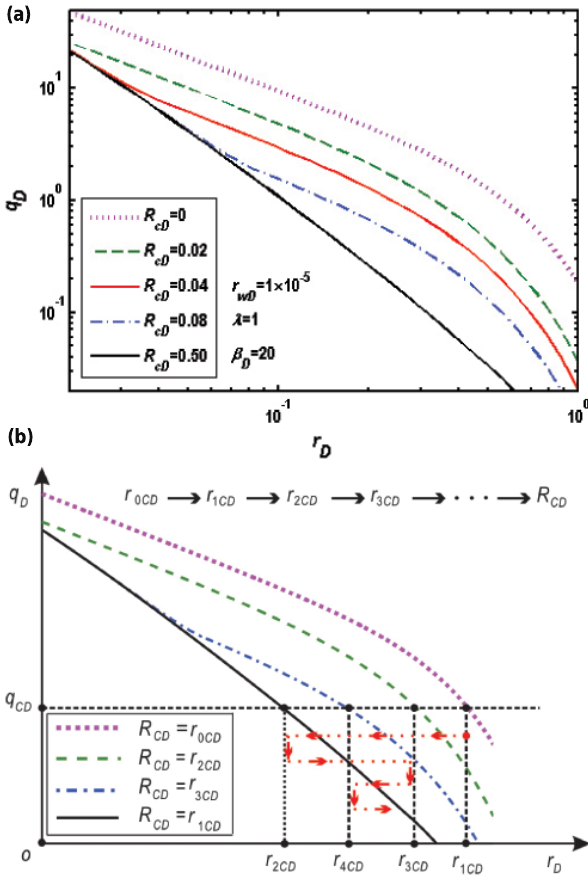
Figure 2. (a) Specific discharge distributions with different critical radius R CD . (b) The schematic diagram showing the iterative pro- cess of seeking R CD .